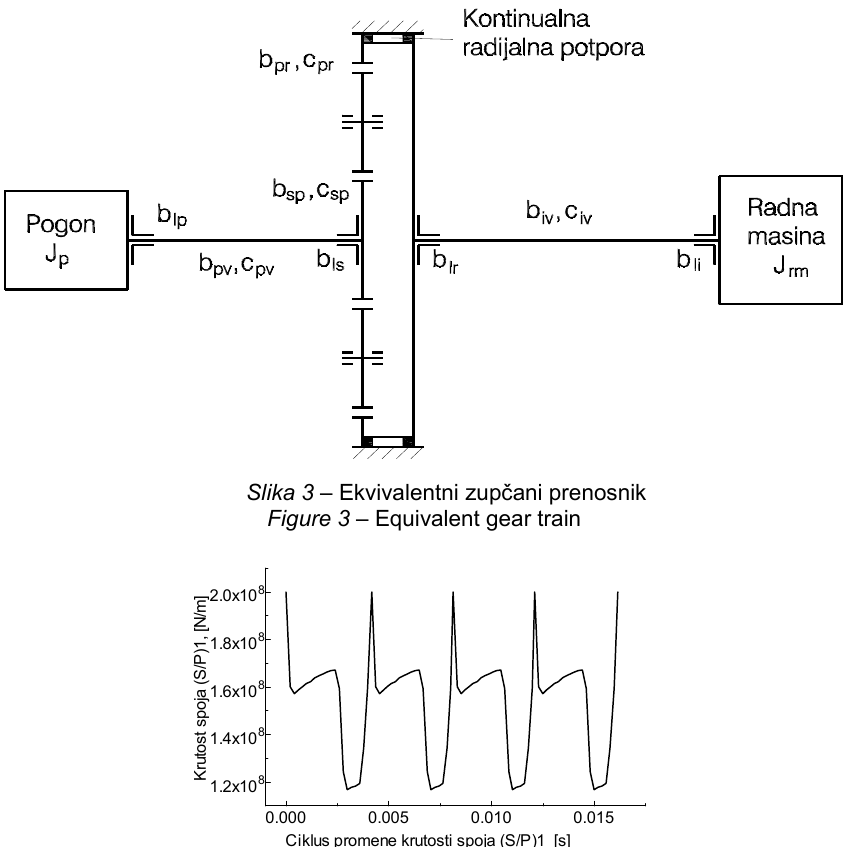
Figure 3 – Equivalent gear